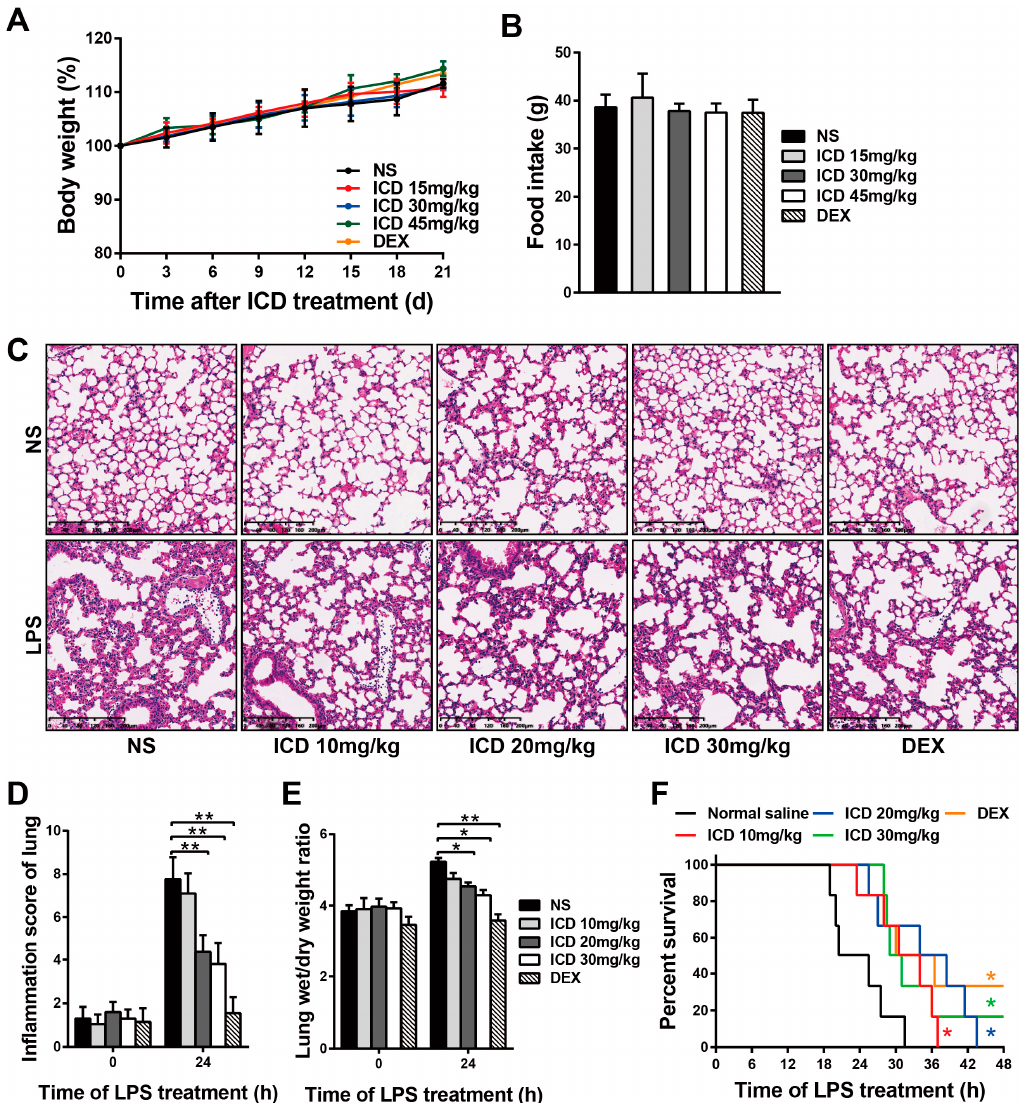
Figure 2. Protective effects of isocorydine on LPS-induced acute lung injury in mice. Body weight ( A ) and food intake ( B ) were monitored for 21 days in mice intraperitoneally injected with different doses of ICD and DEX (5 mg/kg). LPS-induced acute lung injury mouse model was established. ( C ) H&E staining of lung tissues. Scale bars, 200 µ m. ( D ) Inflammation score of lungs. ( E ) Lung wet/dry weight ratios. ( F ) Statistics of survival time in ICD and control groups after LPS treatment. The mean and SD of at least three independent experiments are shown. * p < 0.05, ** p < 0.01 indicate significant differences between groups as determined by a two-tailed paired Student’s t